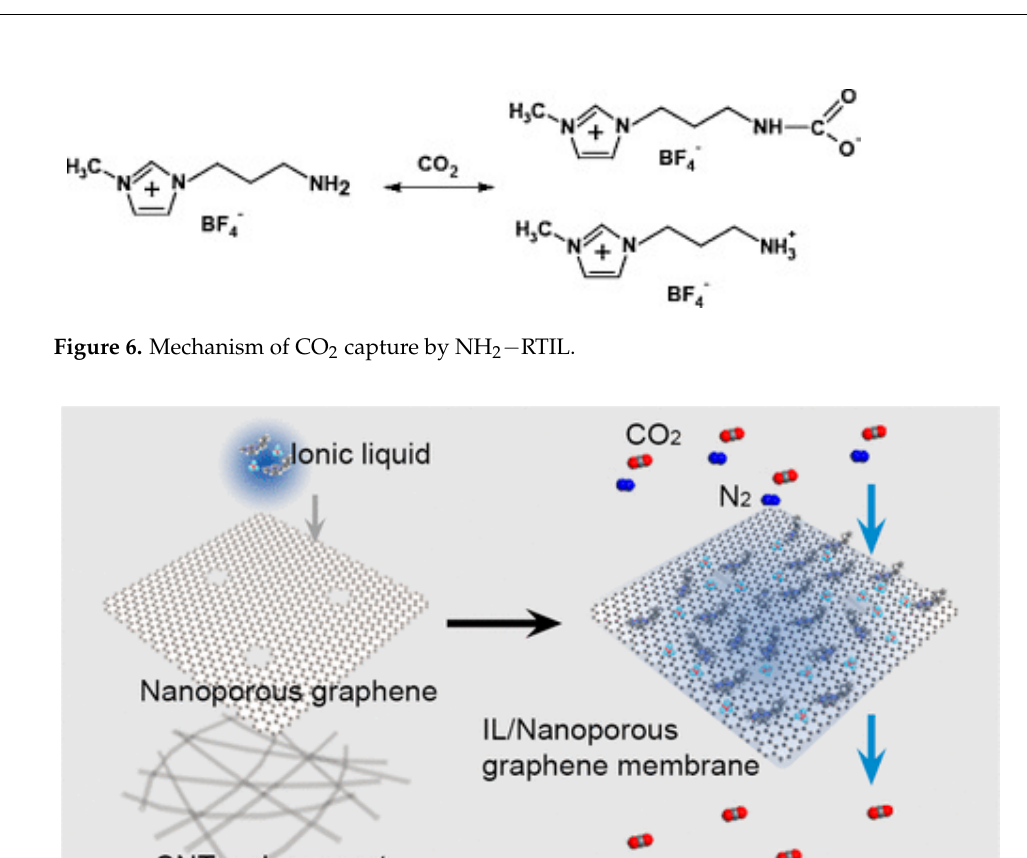
Figure 7. Separation of carbon dioxide and nitrogen by monolayer nanoporous graphene membrane [49]. brane